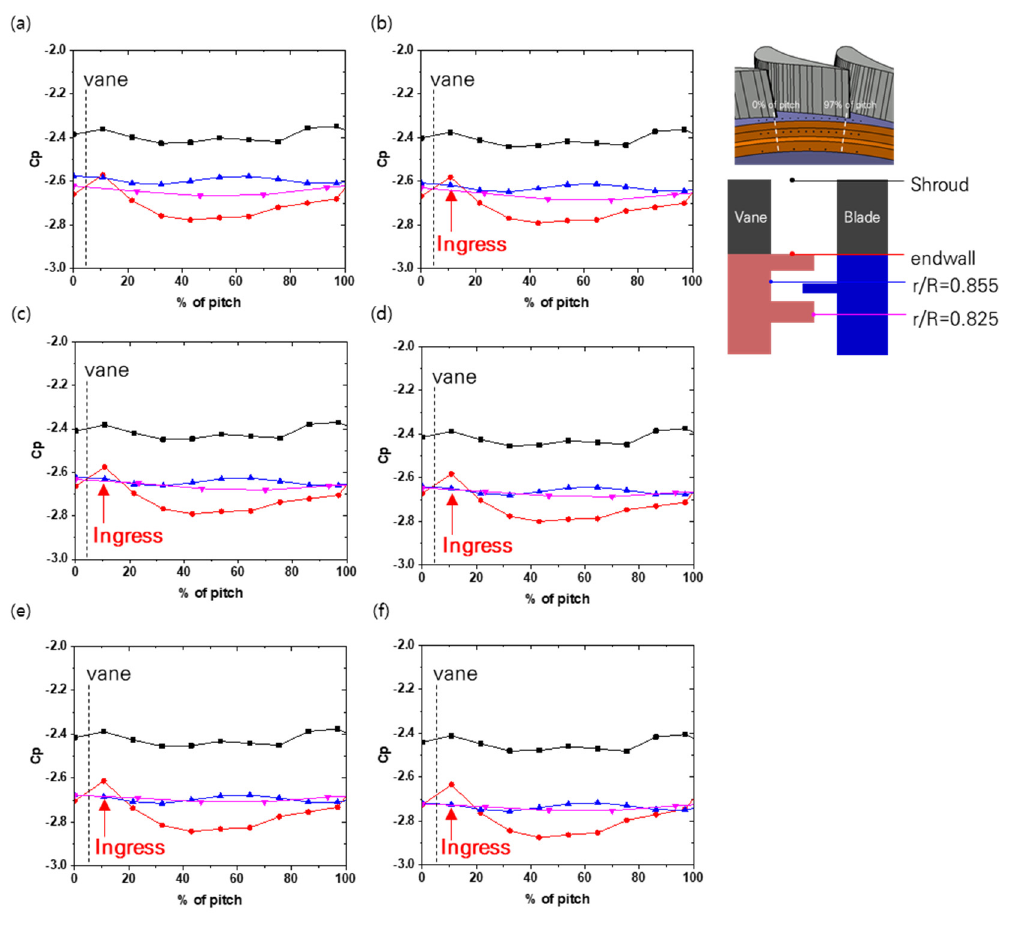
Figure 6. Local pressure distributions: ( a ) 1.35%, ( b ) 1.25%, ( c ) 1.13%, ( d ) 1%, ( e ) 0.75%, and ( f ) 0.5% actual engine air flow at Re Φ ≅ 5.2 × 10 5 . Table 2. Experimental conditions considered in the present